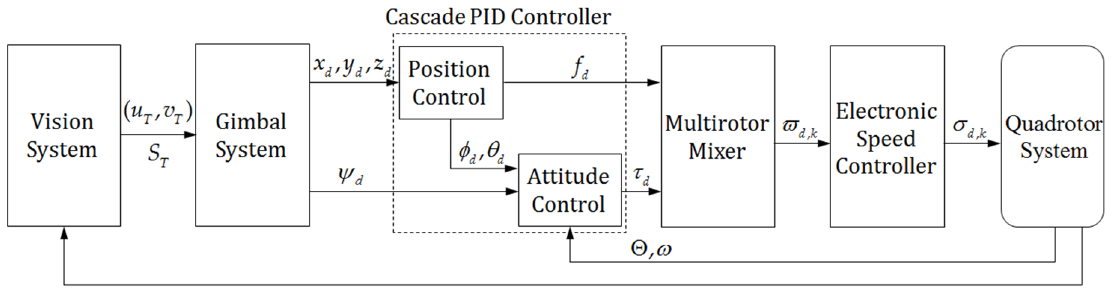
Figure 13. Hierarchical control architecture of the quadrotor for target tracking.